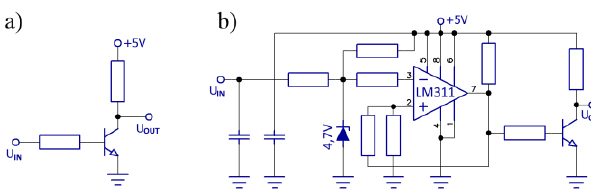
Fig. 5. Examples of two systems of matching the signals in the mechatron- ic systems of the car to the binary form: a) single-stage inverting voltage amplifier, b) voltage comparator with a hysteresis loop